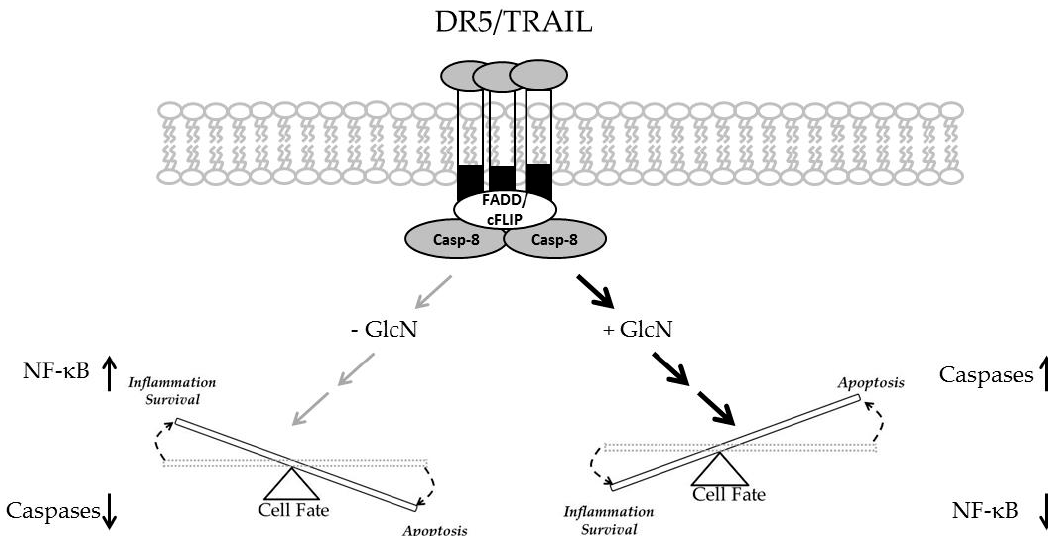
Figure 5. GlcN increases the flux toward apoptosis versus inflammation (anti-apoptotic) in combination treatment with TRAIL. The addition of GlcN / TRAIL increases overall caspase levels and activates molecules associated with the intrinsic apoptotic pathway (i.e., SMAC and cytochrome C). GlcN / TRAIL also reduces inflammatory pathways by reducing NF-kB levels which are typically stimulated by TRAIL treatment alone.